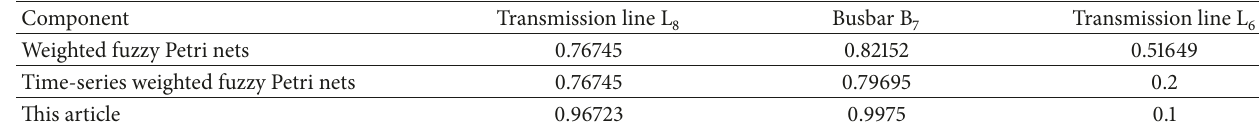
Table 1: Comparison of the fault degree of the two methods in study [20].